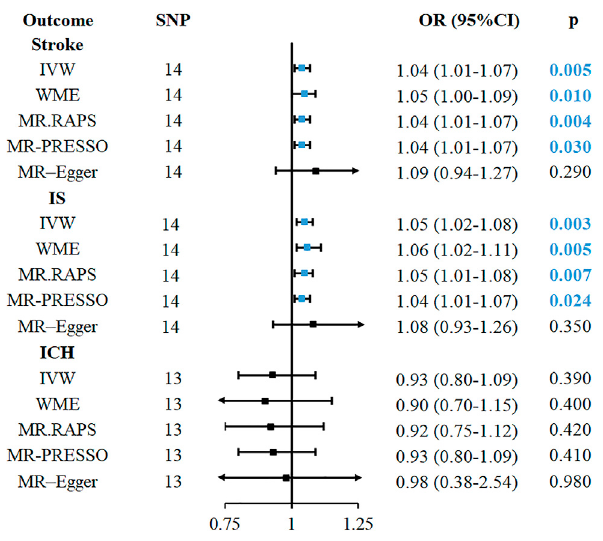
FIGURE 2 | The causal relationship between childhood obesity and risk of stroke and its subtype in Mendelian randomisation. CI, con fi dence interval; IVW, inverse-variance-weighted; MR, Mendelian randomization; OR, odds ratio; SNP, single nucleotide polymorphism; IS, ischemic stroke; LAS, large vessel ischemic stroke; CES, cardioembolic ischemic stroke; SVS, small vessel ischemic stroke, ICH, intracerebral hemorrhage; MR. RAPS, MR- RobustAdjustedPro fi leScore;MR-PRESSO,MRpleiotropyresidualsumand